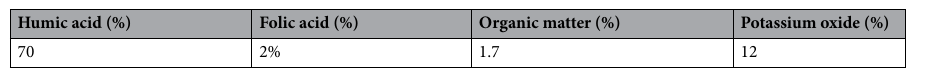
Humic acid (%) Folic acid